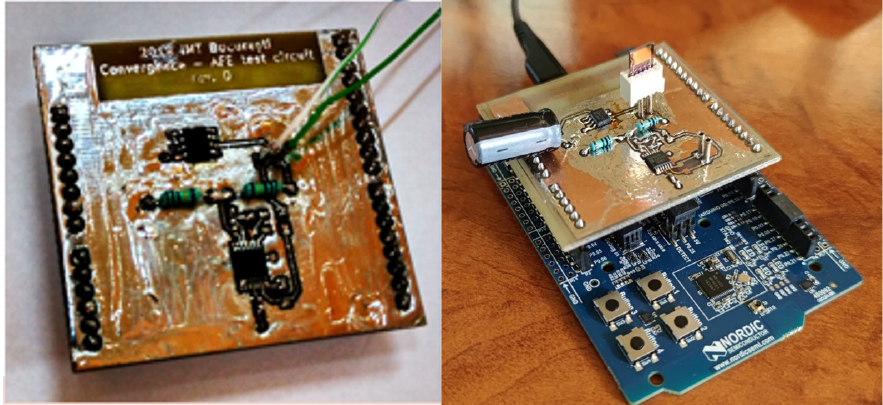
Figure 2 Figure 2. ( a ) Fabricated AFE circuit for interfacing the sensor to the microcontroller development board; ( b ) electronic readout test